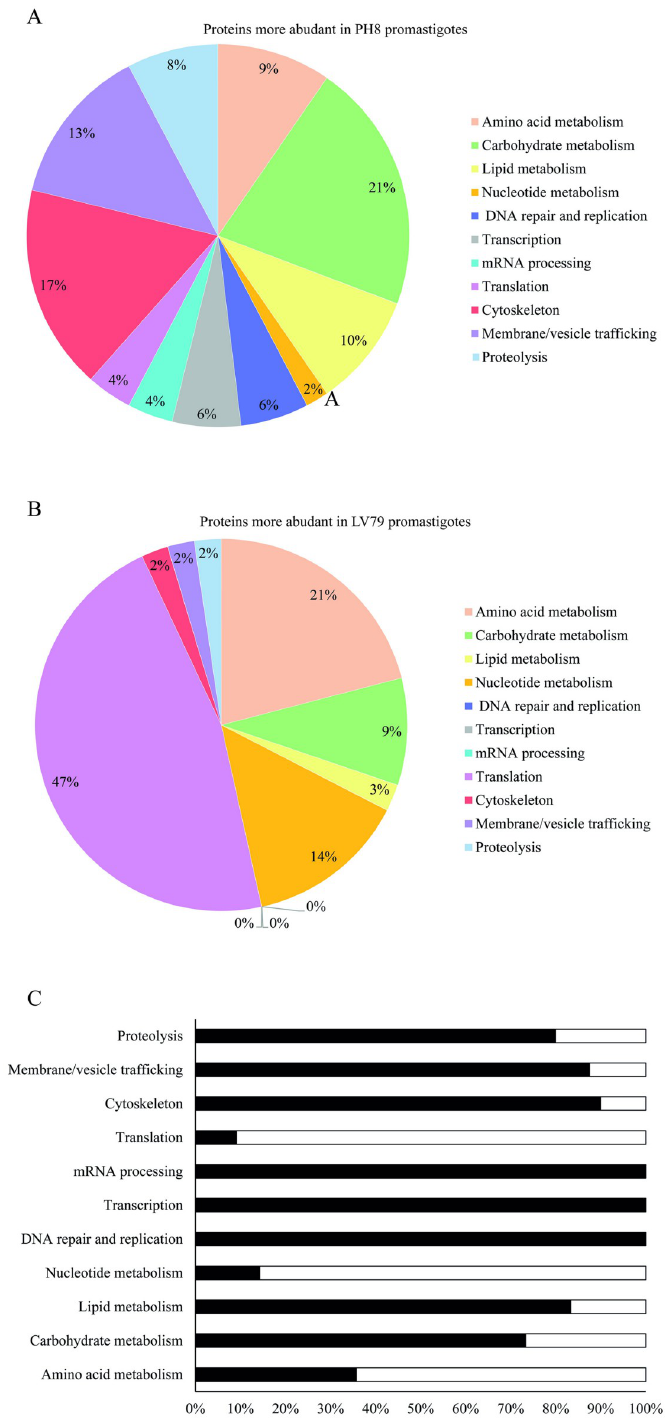
Fig 5. Classification of differentially abundant proteins based on biological process. A. Circle chart showing percentage of the proteins more abundant in PH8 promastigotes belonging to each biological process. B. Circle chart showing percentage of the proteins more abundant in LV79 promastigotes belonging to each biological process. C. Bar diagram showing the percentage of differential proteins from each biological process detected as more abundant in LV79 and in PH8